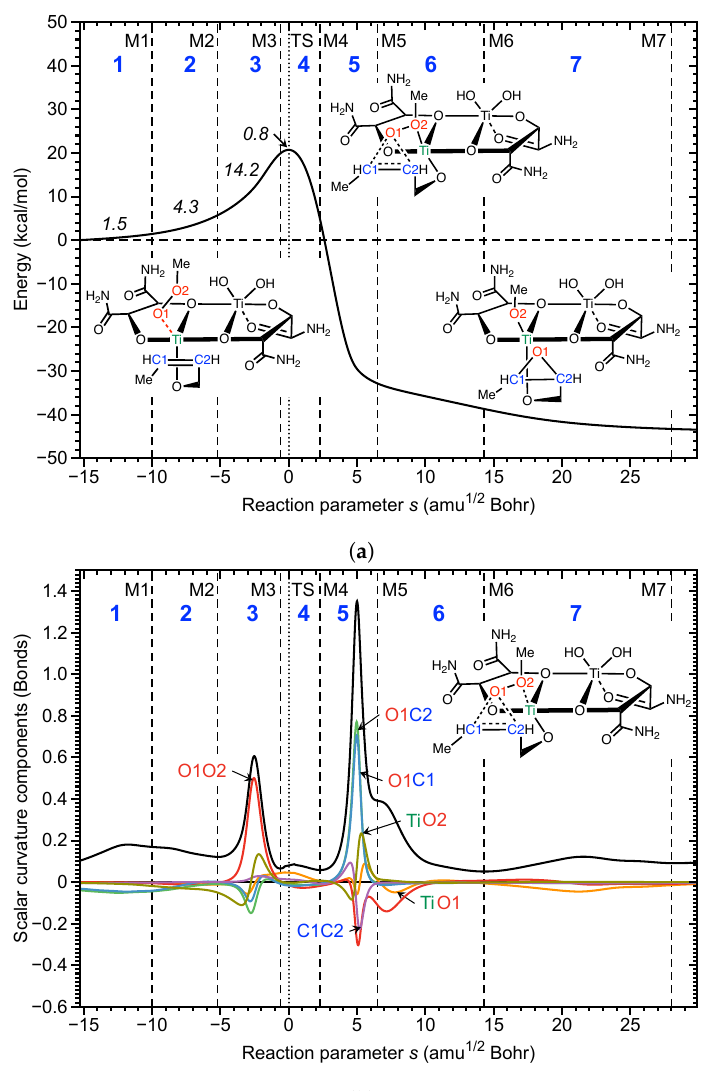
Figure 4. ( a ) Energy diagram of the Sharpless epoxidation reaction. The energy amount consumed in each phase up to the TS is shown in italics. ( b ) Corresponding curvature profile including most important curvature components. The reaction curvature as a function of s is shown as a solid black line; the curvature components are shown as solid colored lines. The borders of the reaction phases are indicated by vertical dashed lines at curvature minima M1, M2, M3, etc. The reaction phases are indicated by blue numbers. The TS at s = 0 amu 1/2 Bohr is also indicated by a vertical dotted line. B3LYP/6-31G(d,p)/SDD level of